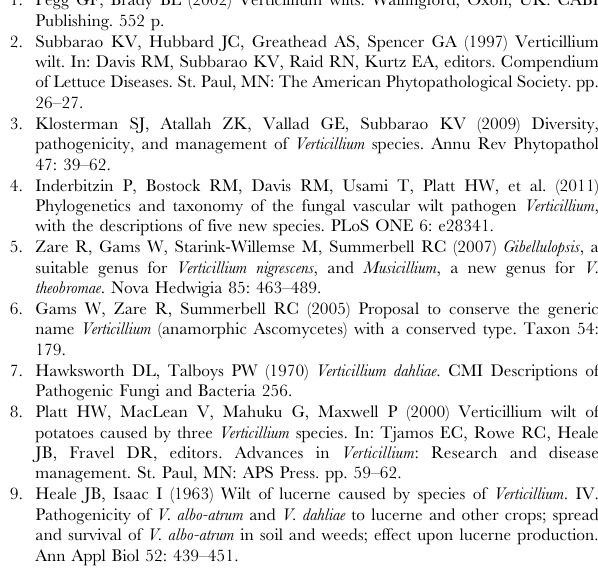
Figure S4 Phylogenetic trees confirming the identifica- tion of previously genetically uncharacterized strains